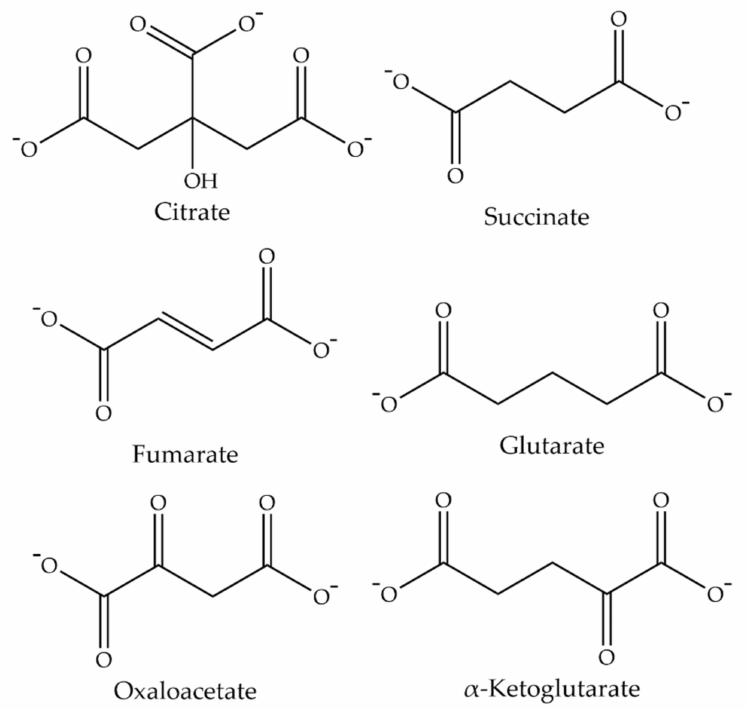
Figure 2. Chemical structures of substrates for Drosophila INDY. At physiological pH, citrate exists as a trivalent anion, whereas all other substrates exist as divalent